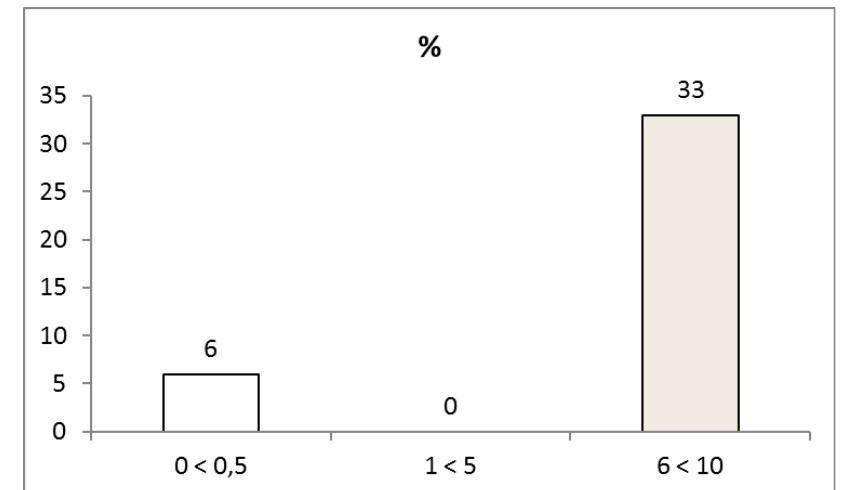
Figure 3. The injury rate depending on years of experience in skiing